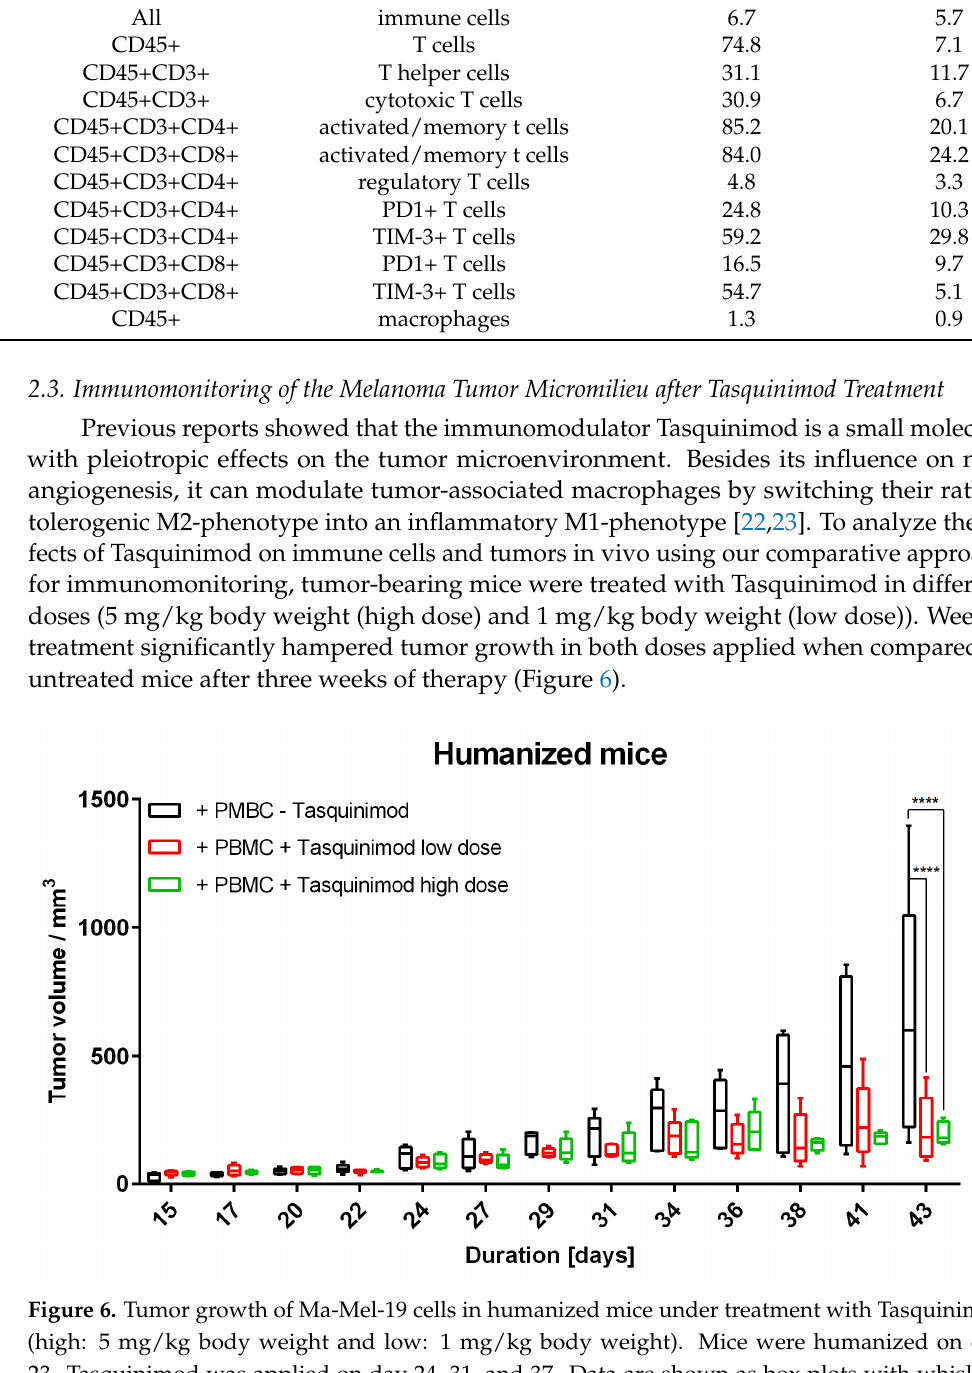
Table 1. Immune cell subpopulations in untreated tumor-bearing animals detected by Chipcytometry (n = 3). Marker Definition